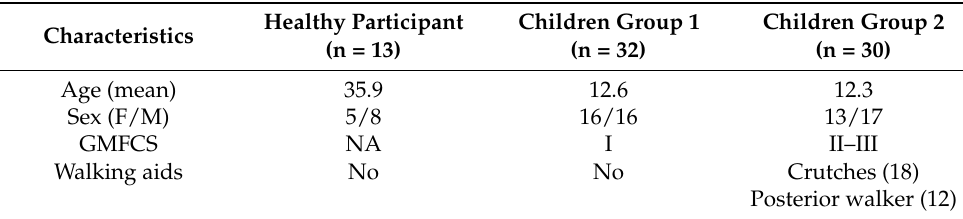
Table 1. Characteristics of population included.